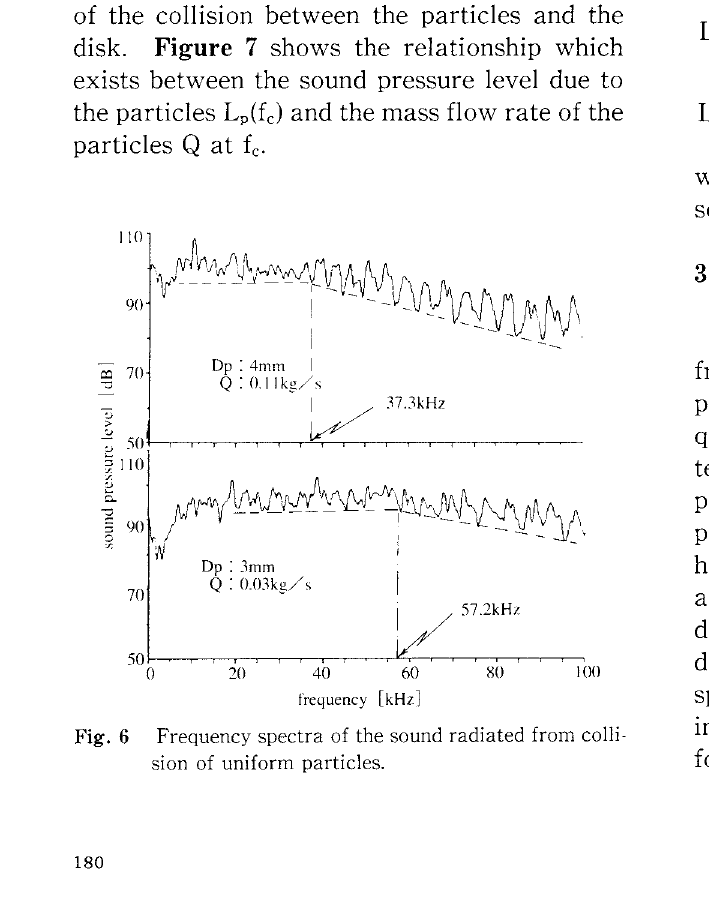
Fig. 7 Relationship between sound pressure level and mass flow rate of